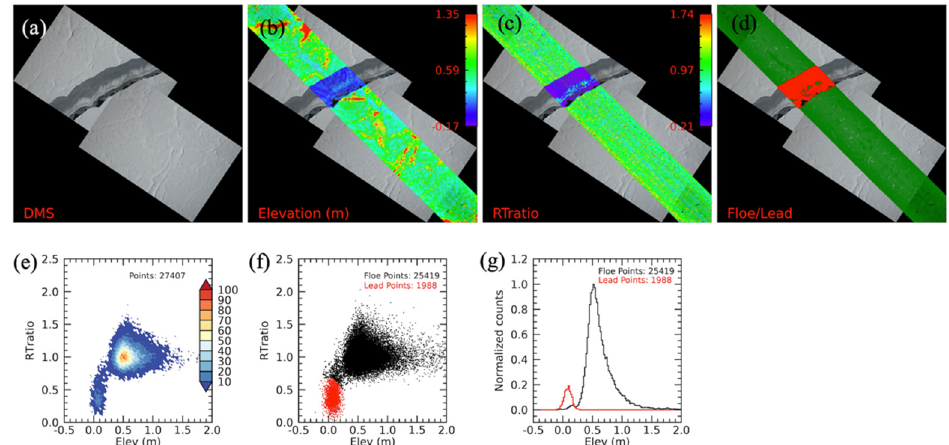
Figure 2. An example from 21 April 2016 shows the cluster analysis method results. ( a ) DMS images. ( b – d ) ATM elevation, RTratio, and floe (green) and lead (red) footprints on top of the DMS images. ( e ) Color-coded Elevation-RTratio scatter plot. ( f ) Elevation-RTratio scatterplot, and floe (black) and lead (red) from the cluster analysis. ( g ) The pdf of floe (black) and lead (red) normalized by floe pdf amplitude.